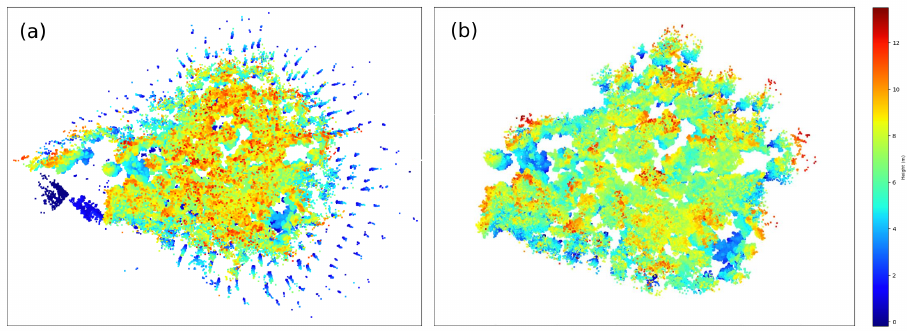
Figure 5. ( a ) Raw point cloud. ( b ) Outlier removal of the original point